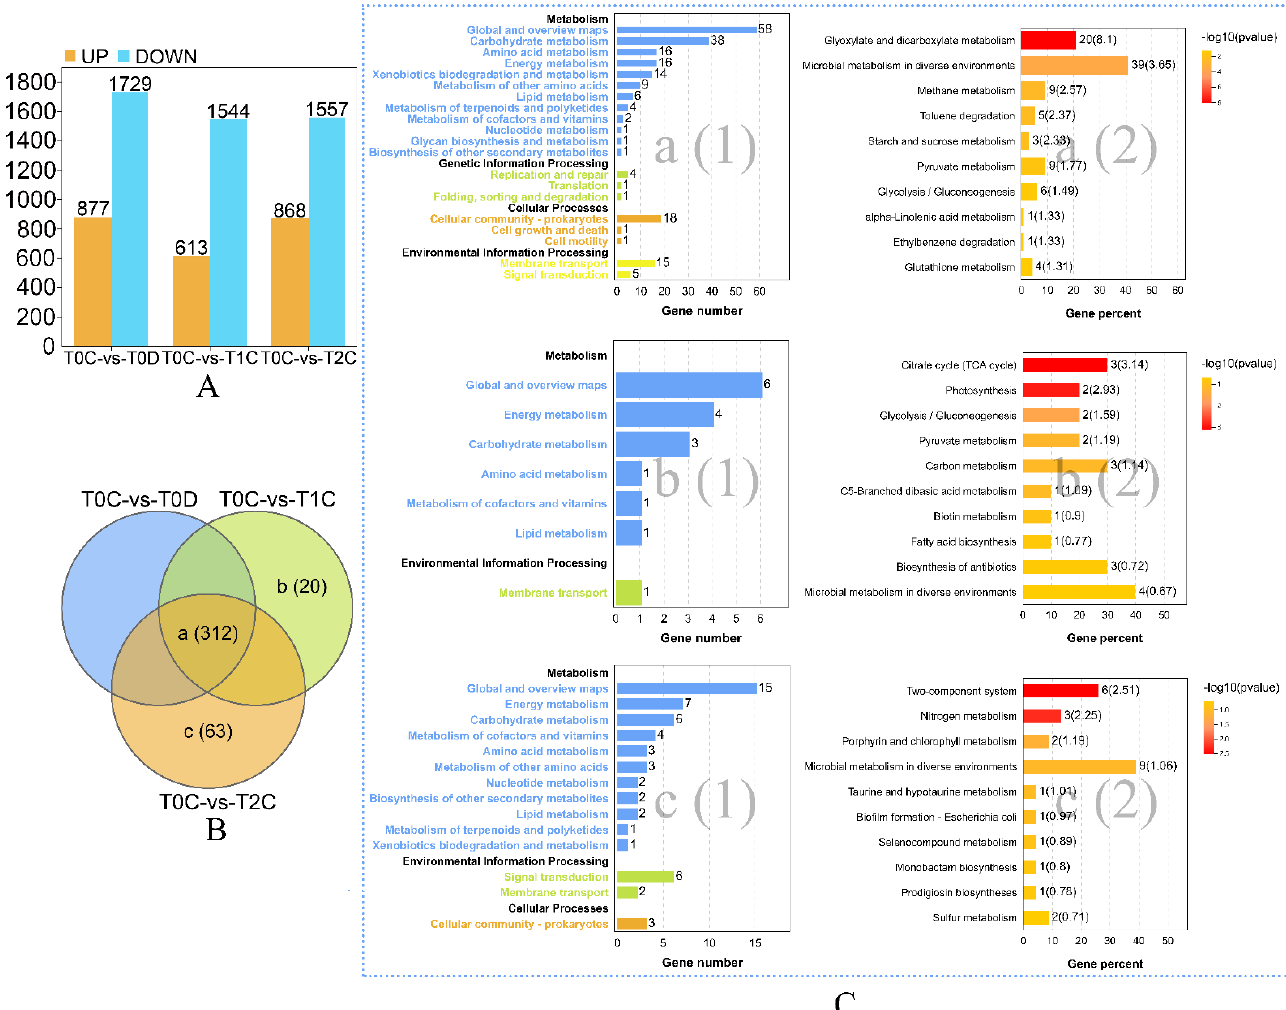
Figure 1. Overview of the strain YN2 transcriptome response to dioxane treatment: ( A ) number of individual transcripts significantly upregulated or downregulated of each group; ( B ) Venn diagram illustrating the classification of upregulated DEGs. Genes were filtered by FPKM ≥ 50 to remove non-essential pathways; ( C ) KEGG pathway enrichment analysis of DEGs of the three classes. Data were visualized using column diagrams. The number of DEGs mapped into each pathway is presented in figure No. (1) of each class and labeled by the end of the column. p -value levels of enriched pathways are presented in figure No. (2) of each class, with the number of components in each pathway present in the DEG dataset labeled by the end of the column, and indicated by “ − log10 ( p value)” and an enrichment factor indicative of individual pathways in